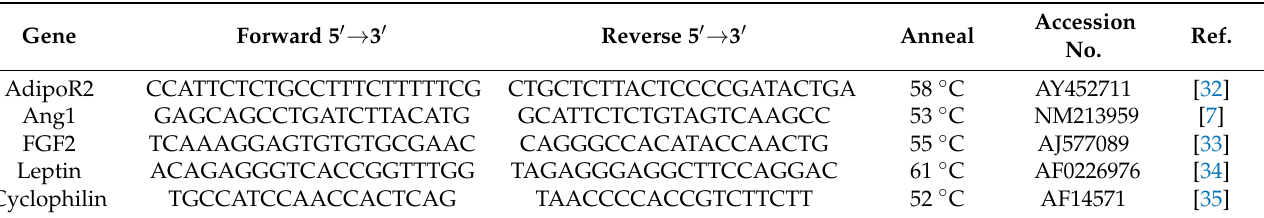
Table 1. Primer sequences for real-time